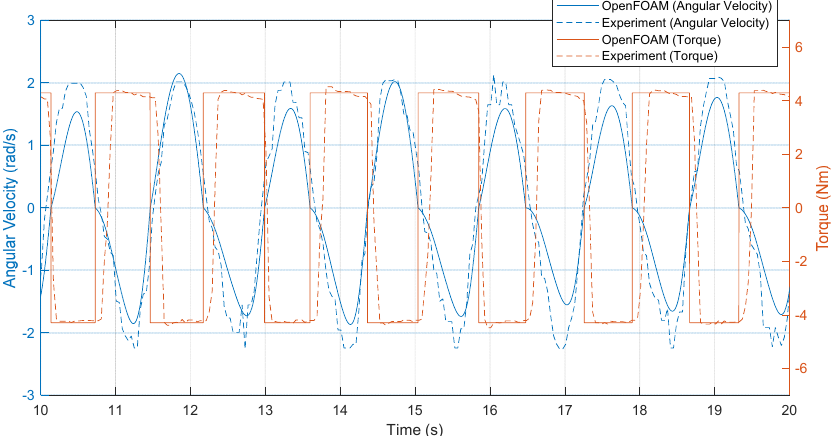
Figure 7. Comparison of time series of pitch angular velocity and power take-off (PTO) load torque of 4.29 Nm between experimental and numerical results.